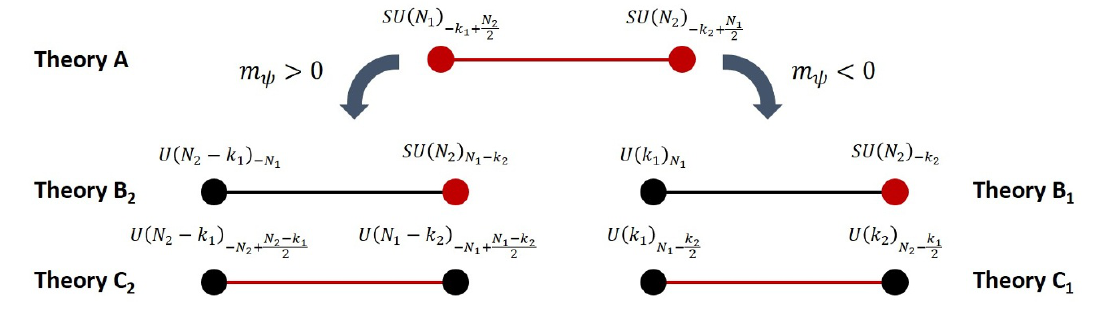
Figure 3 . Generalized fermion quiver duality with (cid:13)avor-violated bosonization duality. The (cid:12)rst step uses the (cid:13)avor-violated 3d bosonization duality, while the second step uses the (cid:13)avor-bounded version. The diagram is valid for the k 1 < N 2 (cid:20) N (cid:3) ( N 2 ; k 1 ) ; k 2 < N 1 (cid:20) N (cid:3) ( N 1 ; k 2